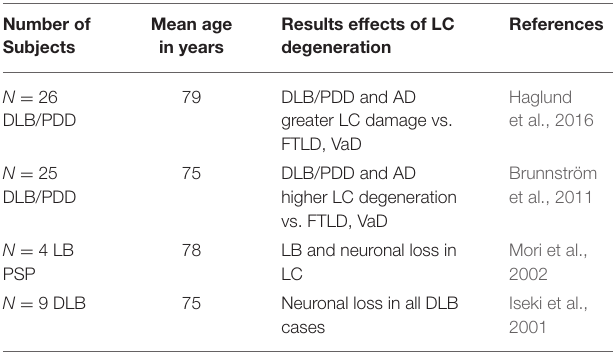
TABLE 1 | Studies involving degeneration of locus coeruleus—noradrenaline system in patients with dementia with Lewy